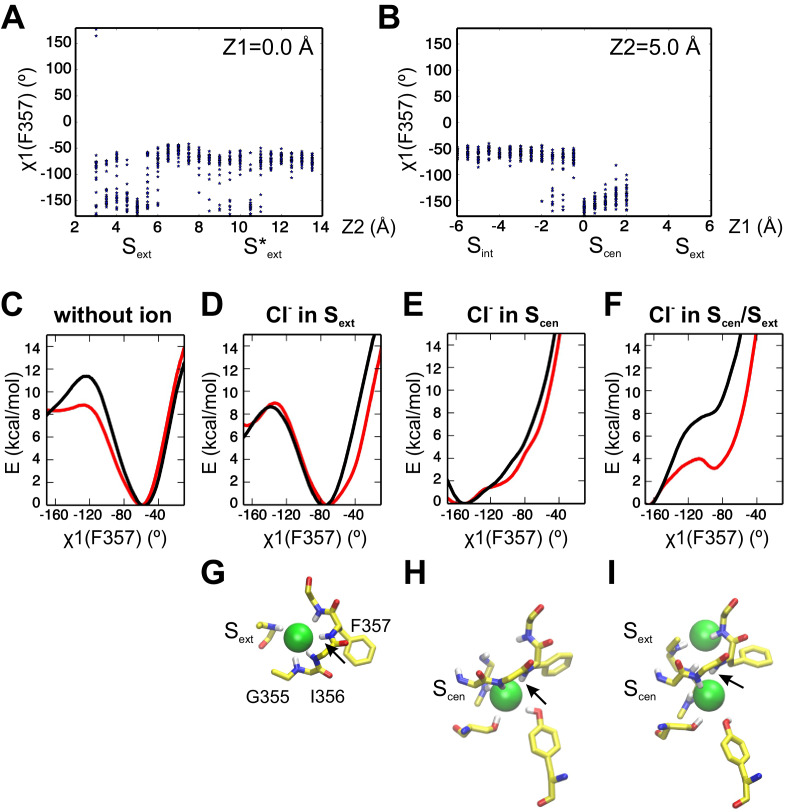
Ion binding influences the conformation of the F357 side chain.(A, B) The conformational sampling underlying the PMF of Figure 2A reveals large fluctuations of F357 χ1 angle when a Cl- visits the Scen binding site. The Scen/Sext doubly occupied state correspond to the coordinate (Z1, Z2)=(0.0, 5.0). The distribution of F357 χ1 values is plotted for each simulation window along the axes Z1 = 0.0 Å (A) and Z2 = 5.0 Å (B). (C–F) The PMF along F357 χ1 angle is shown for different occupancy states: in absence of ions (C), with a Cl- in Sext (D) or Scen (E), and with Cl- in both Scen and Sext (F). The PMF calculations were initiated with the F357 side chain in the up state (χ1=-160°, black) or the down state (χ1=-70°, red). (G–I) Molecular representations of the coordination scheme for ions in Sext (G), Scen (H), and Scen/Sext (I). The structures correspond to the free energy minimum of the PMF in panel (D), (E) and (F), respectively. The backbone conformation of residues I356 and F357 responds to the ion occupancy state, impacting on the preferred conformer of the F357 side chain. The black arrow indicates the NH group of F357.